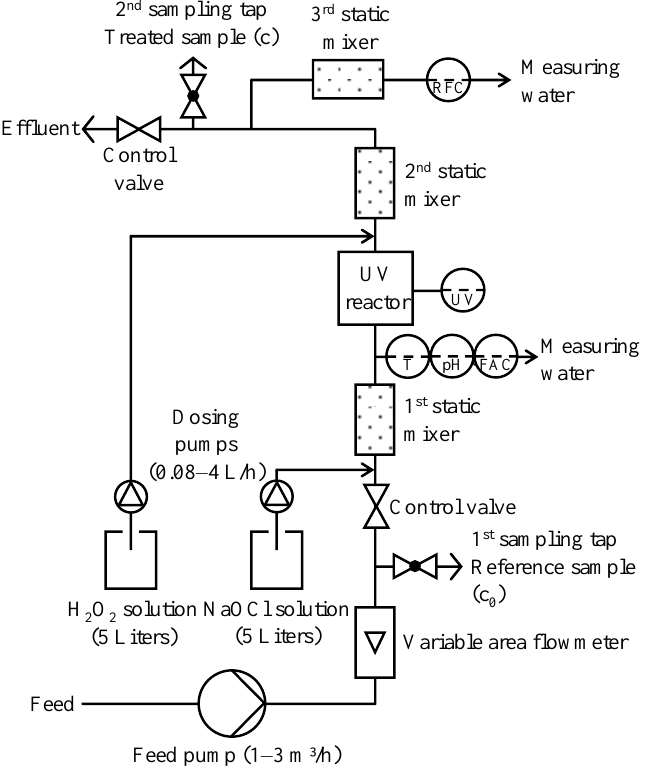
Figure 3. Technical scheme of the UV/chlorine AOP pilot plant (with changes from Rott et al. [7]).